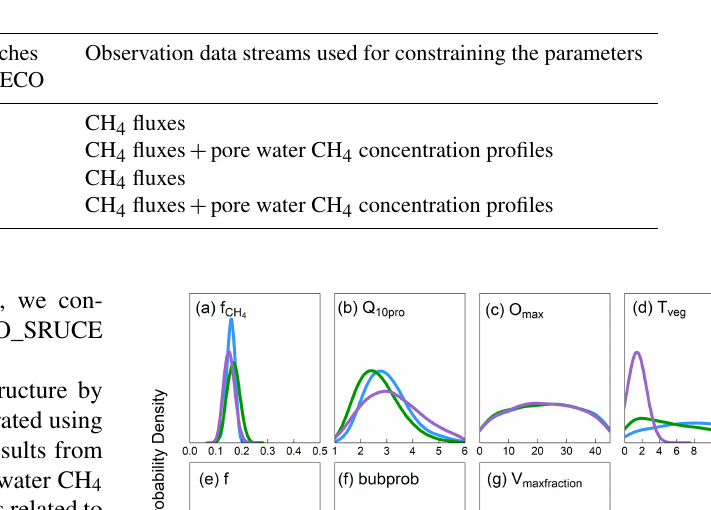
Table 3. Details for data assimilation runs.